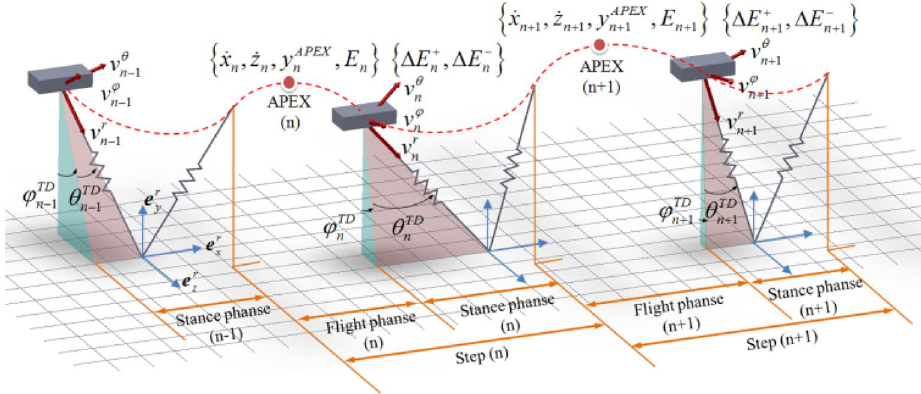
Figure 4. 3D-SLIP running period including flight and stance phase in